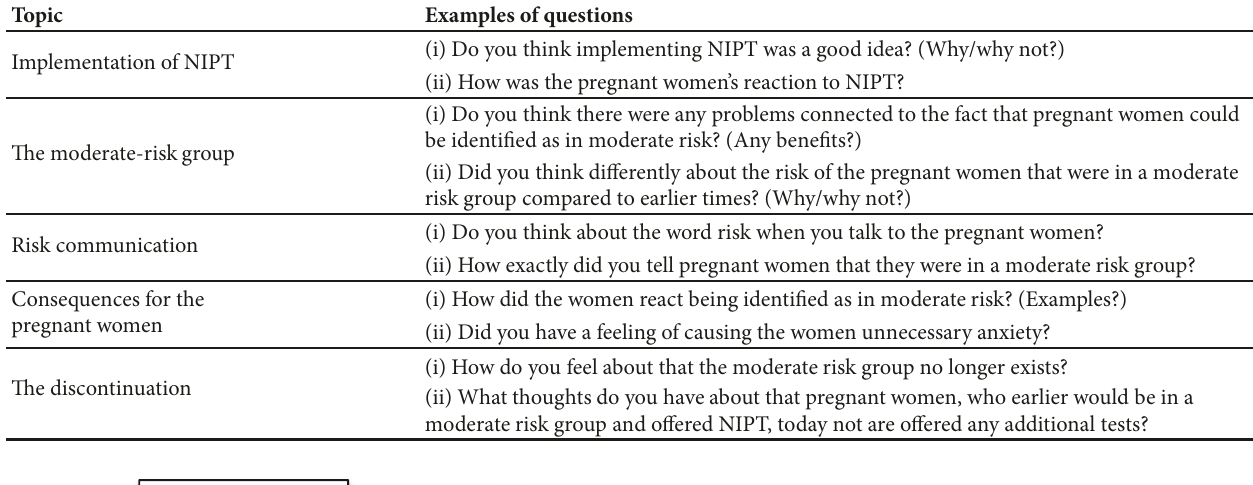
Table 2: Topic guide .